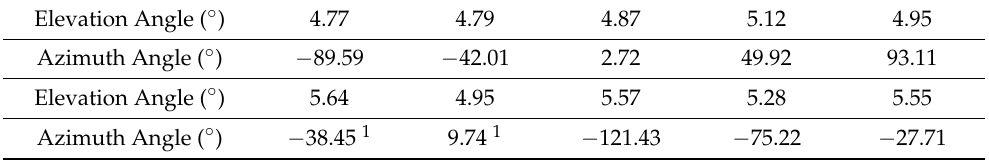
Table 19. DOA estimation by CPCMA-ESPRIT for inner race fault signal at 725 rpm.